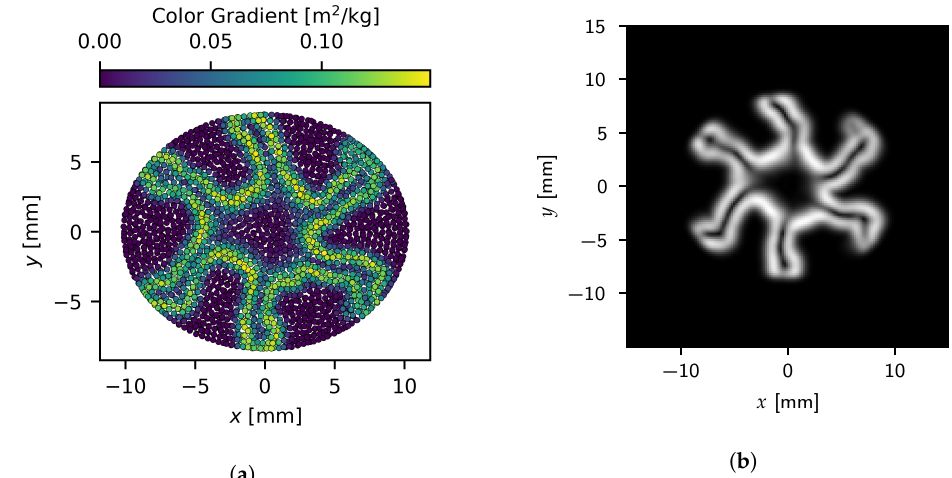
Figure 2. A comparison between the ( a ) instantaneous color gradient magnitude at the particle level and ( b ) the image generated from the particle